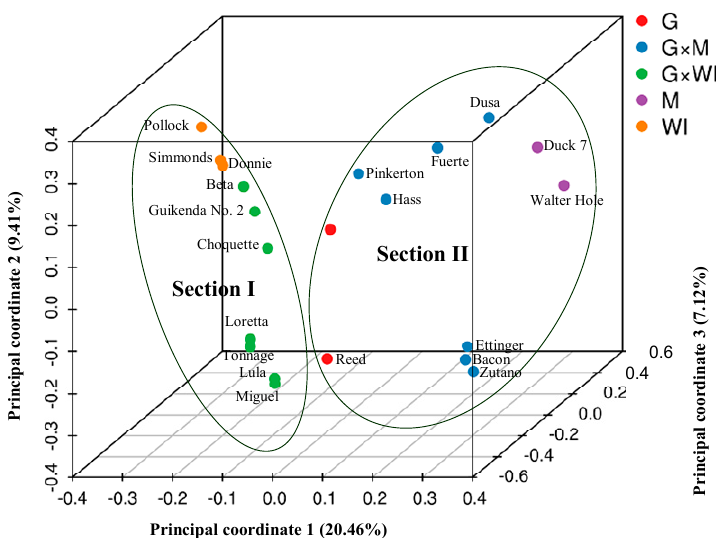
Figure 2. Principal coordinate analysis of the 21 avocado accessions based on 701,352 SNPs from SLAF-seq. M: Mexican, G: Guatemalan, WI: West Indian (interracial hybrids are indicated by ×).